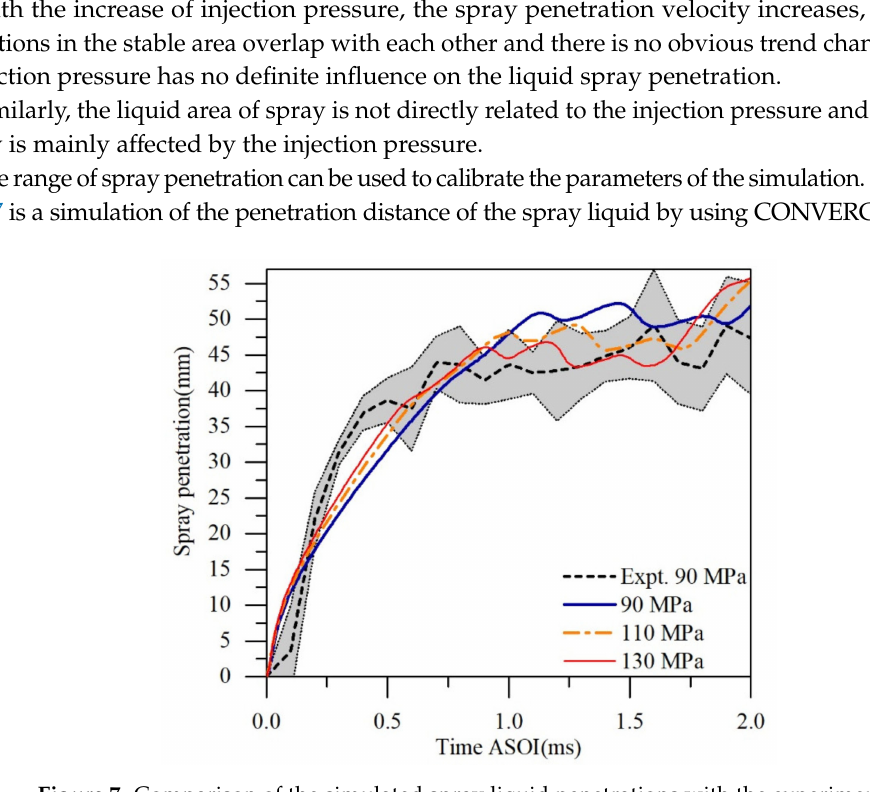
Figure 7. Comparison of the simulated spray liquid penetrations with the